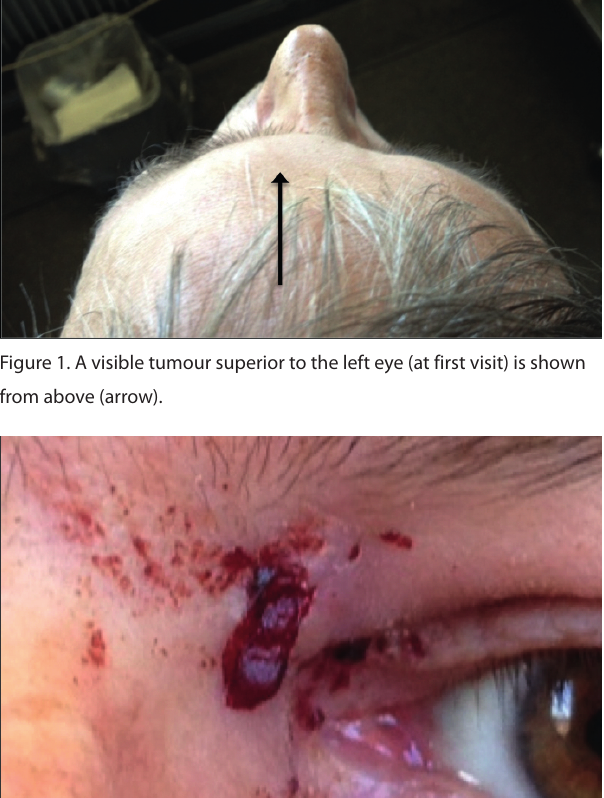
Figure 2. Nasal septal deviation scoring system for nasal endoscopy.